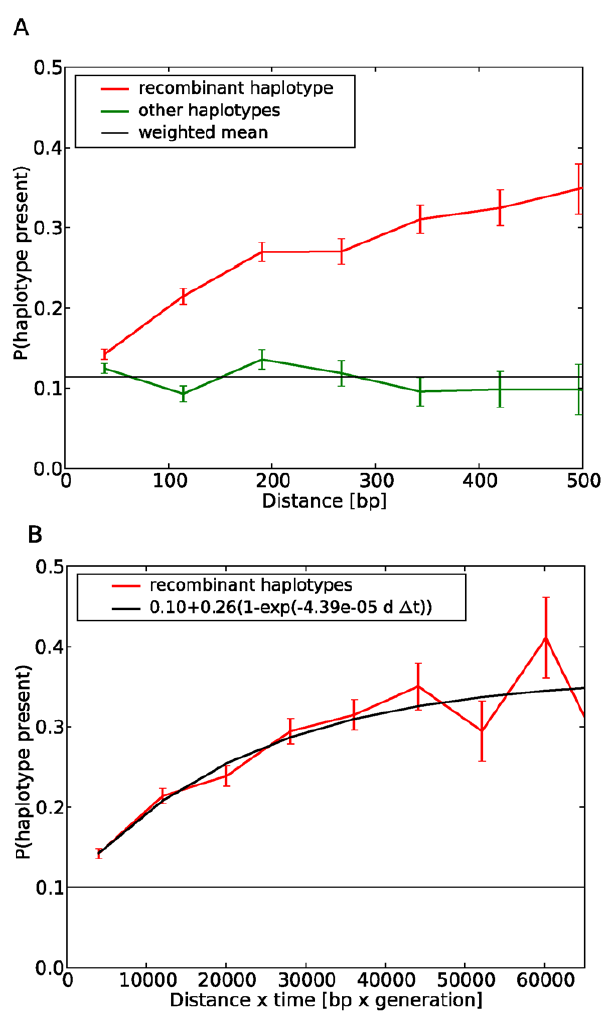
Figure 2. Estimating recombination rates from time resolved data. Panel A shows the probability of finding a haplotype that is not detected at time t i in the sample at t i z 1 as a function of the separation d of the sites. The data labeled ‘recombinant haplotypes’ refers to those combinations, that can be generated by recombination from the alleles detected at time t i and displays a pronounced distance dependence. The data labeled ‘other haplotypes’ refers to pairs containing at least one allele not detected at time t i , implying an additional mutation or undersampling. The data is averaged over all time points, all patients, and those pairs of polymorphic sites, where both alleles at both sites are seen at least 3 times. Panel B shows the probability of finding the missing haplotype as a function of the product of distance d and time interval D t ~ t i z 1 { t i . The fit to the data is shown in black with fit parameters indicated in the